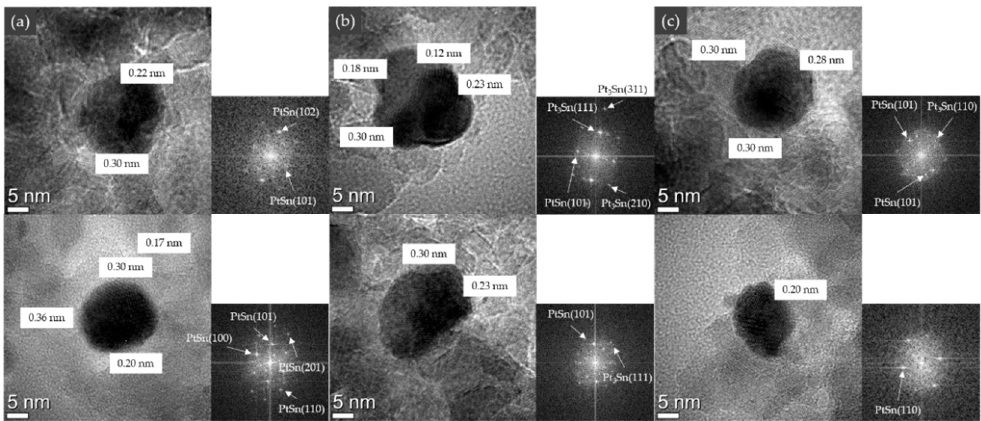
Figure 6. TEM images (inset shows the corresponding FFT pattern) of ( a ) reduced PtSn-B, ( b ) reduced PtSn-B-HCl5, and ( c ) reduced PtSn-B-HCl35.